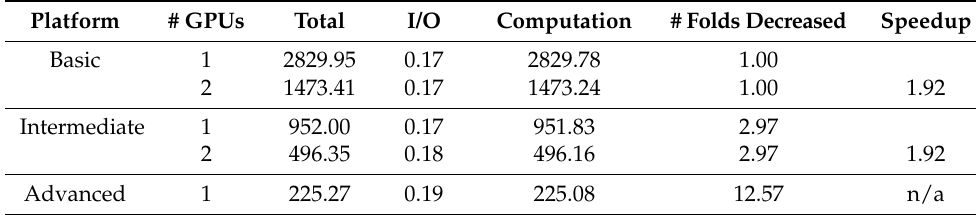
Table 6. Execution time (in seconds) on different computing platforms for density estimation with adaptive bandwidths (no edge effect correction) on a synthetic dataset ( n = 1,000,000 points; density raster cell size = 0.05).